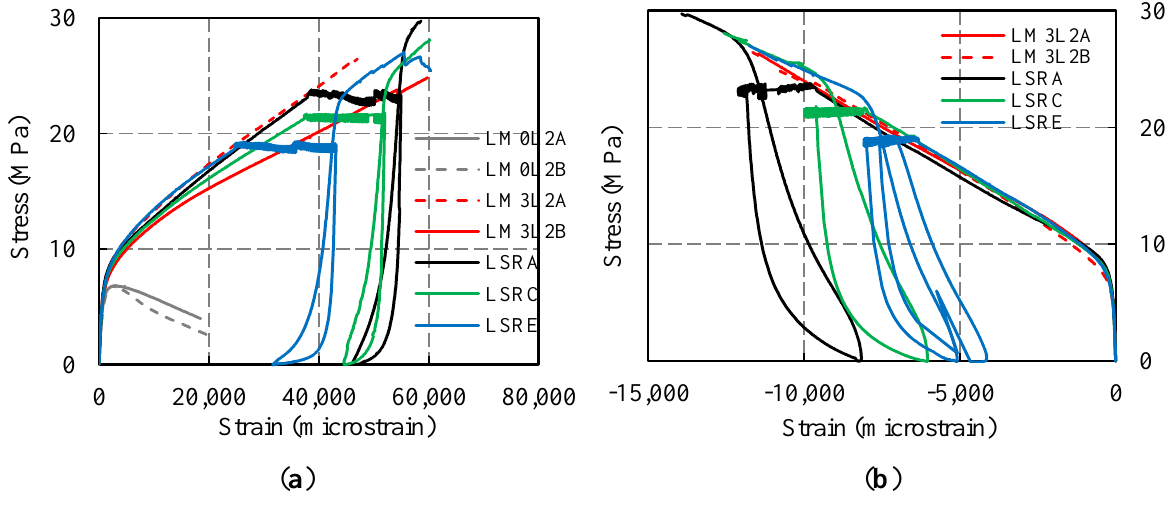
Figure 12. Medium-strength concrete residual capacity tests after 48 h of sustained loading. ( a ) Axial stress-axial strain curves. ( b ) Axial stress-lateral strain